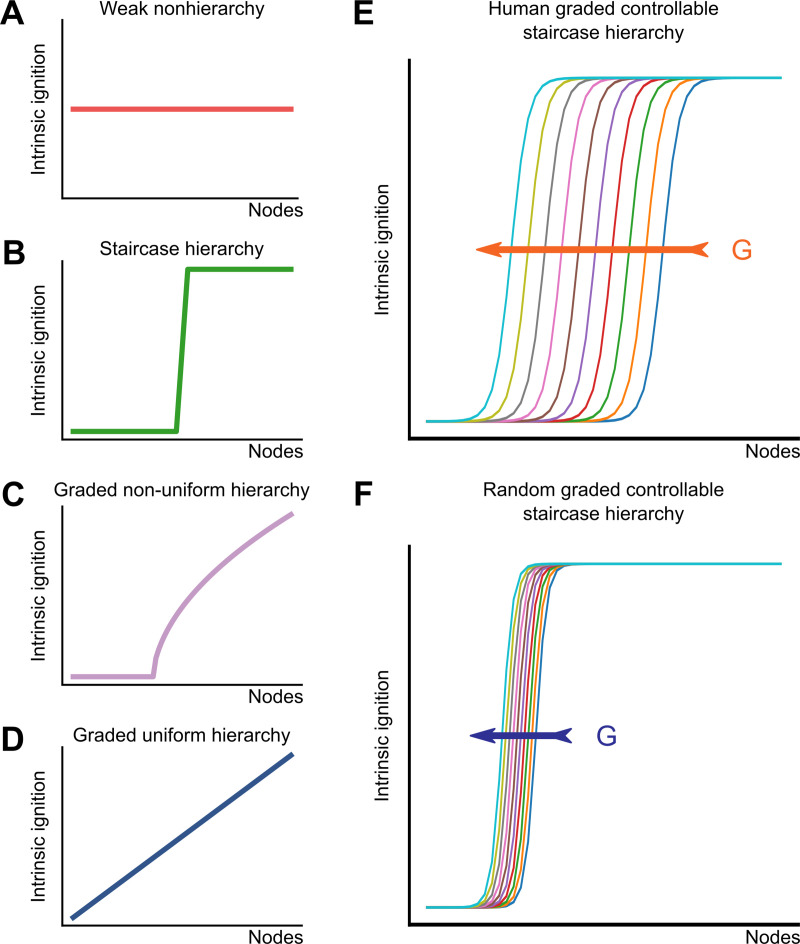
The intrinsic ignition framework.Deco and Kringelbach [22] define four classes of network ignition, that range from (A) weak nonhierarchy to (D) graded uniform hierarchy. Between these poles, two other classes are (B) staircase hierarchy and (C) graded non-uniform hierarchy. (E) In the Human connectome, the number of nodes susceptible to be ignited is smoothly controlled by the coupling gain, as shown in the orange arrow. In the (F)
DPRrw the number of ignited nodes is less controllable.